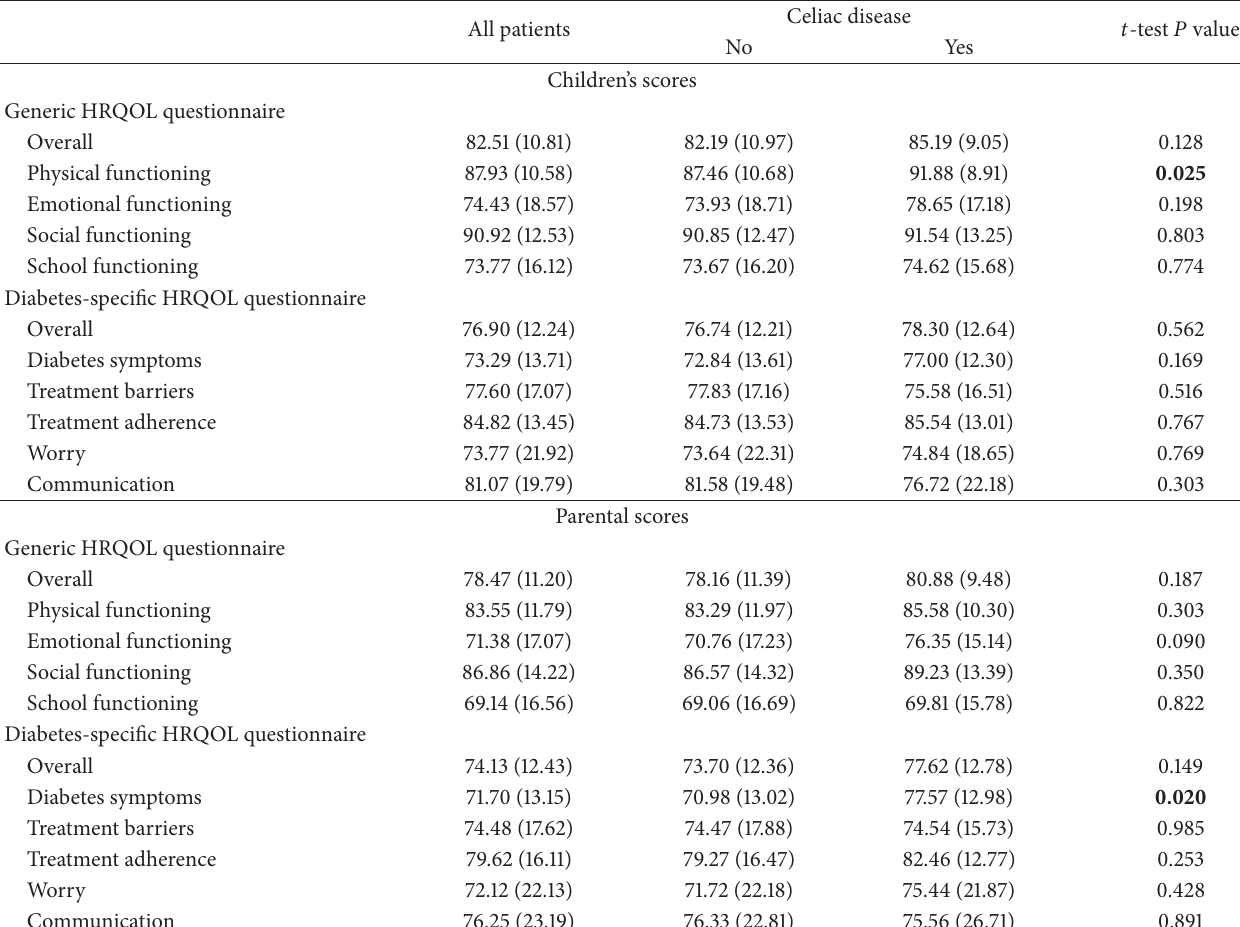
Table 4: Quality of life assessed using the HRQOL questionnaires, by presence of celiac